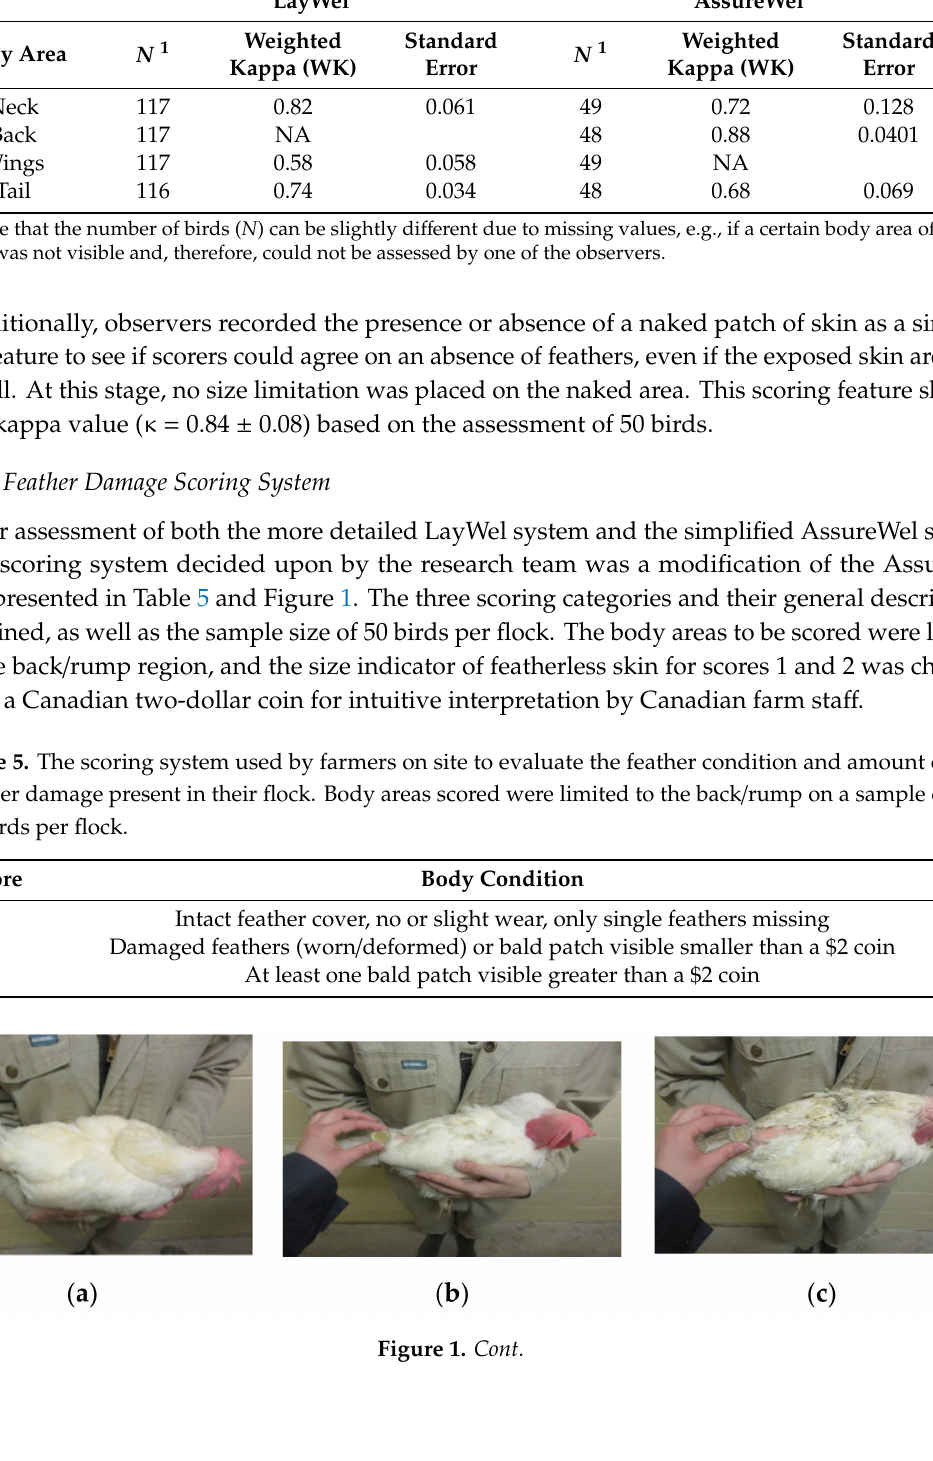
Table 4. Inter-observer reliability of feather damage (FD) scoring of di ff erent body areas in laying hens based on two existing scoring systems using numeric scales (LayWel, 1–4 scale and AssureWel, 0–2 scale) between two principal members of the research team. Reliability was assessed as weighted kappa (WK). Not applicable (NA) indicates cases where WK could not be calculated due to the fact that not all the same score categories were used. LayWel